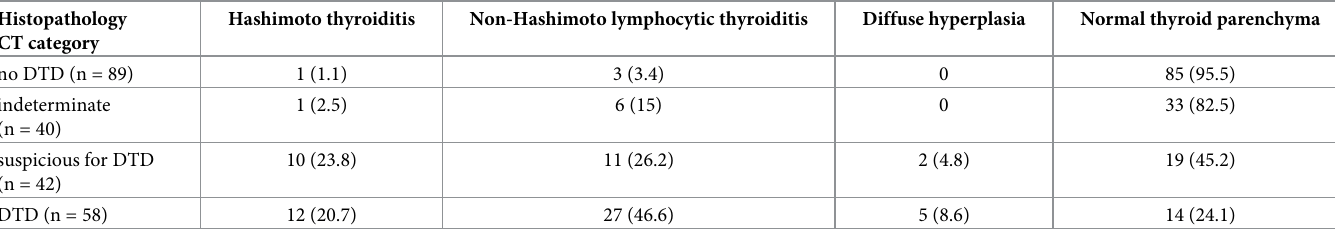
Table 2. Comparison of the computed tomography diagnoses and histopathological results in 229 patients. Histopathology CT